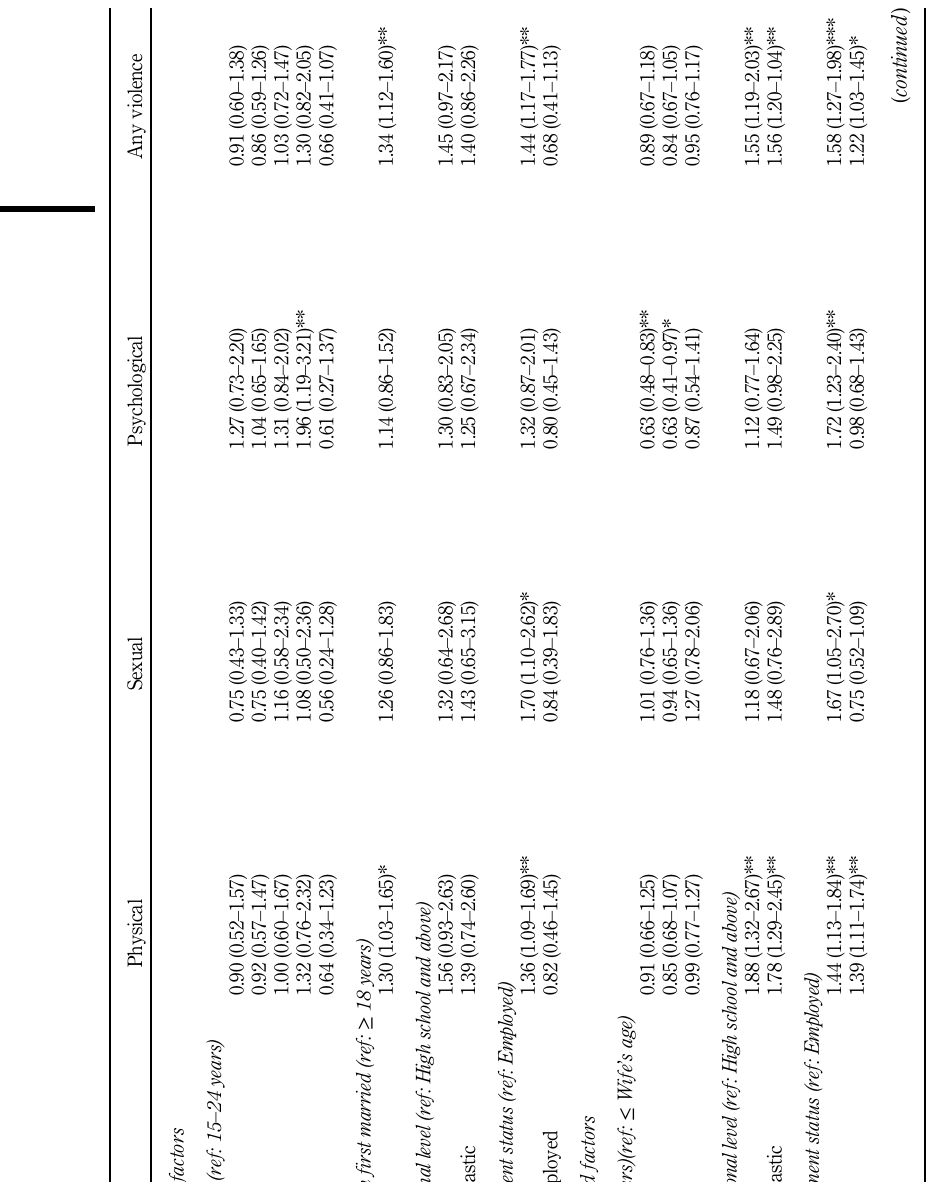
Table 2. Unadjusted associations between independent variables and different forms of and any